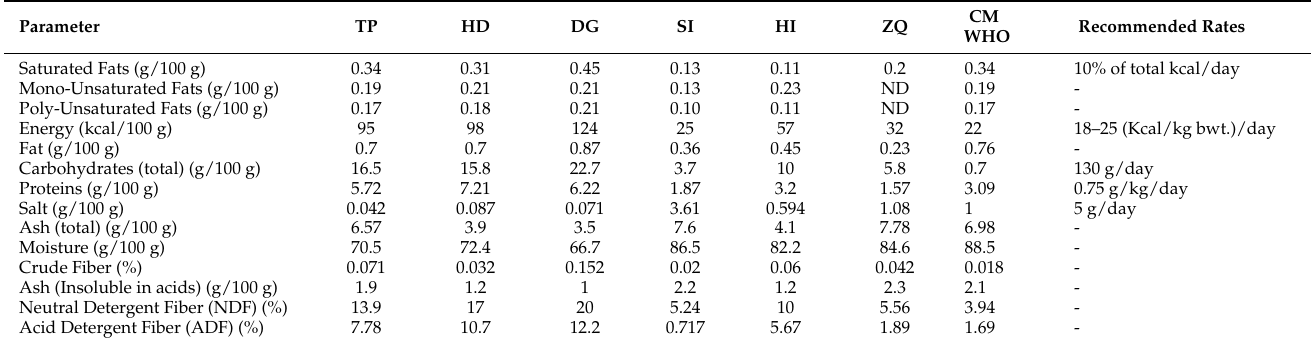
TP— Tribulus pentandrus ; HD— Heliotropium digynum ; DG— Digiterygium glaucum ; SI— Salsola imbricata ; HI— Heliotropium kotschyi ; ZQ— Zygophyllum qatarense ; CM— Chenopodium murale ; bwt—body weight; ND—not